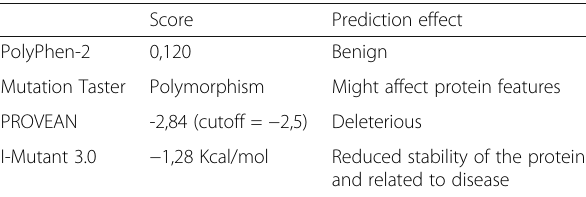
Table 4 In silico protein prediction effect of DAND5 p.Arg152His alteration